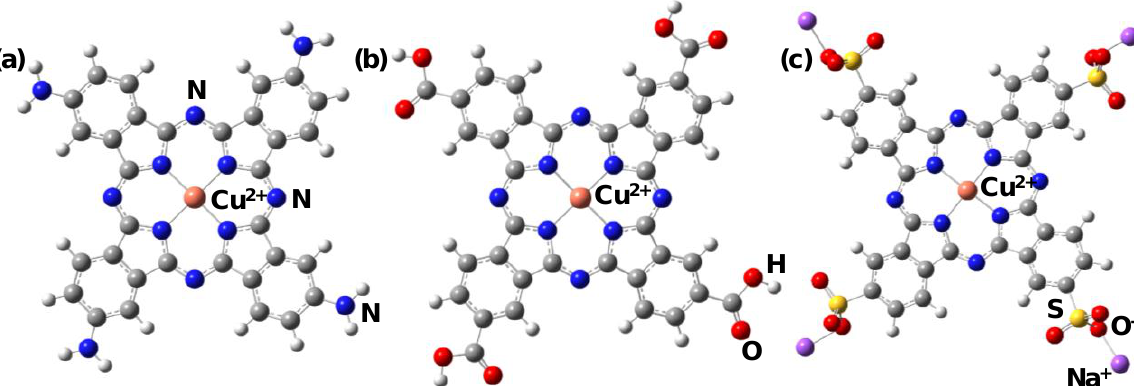
Figure 1. Molecular structures of copper (II) phthalocyanine complexes: ( a ) CuPc(NH 2 ) 4 ; ( b ) CuPc(COOH) 4 ; and ( c ) CuPc(SO 3 Na) 4.